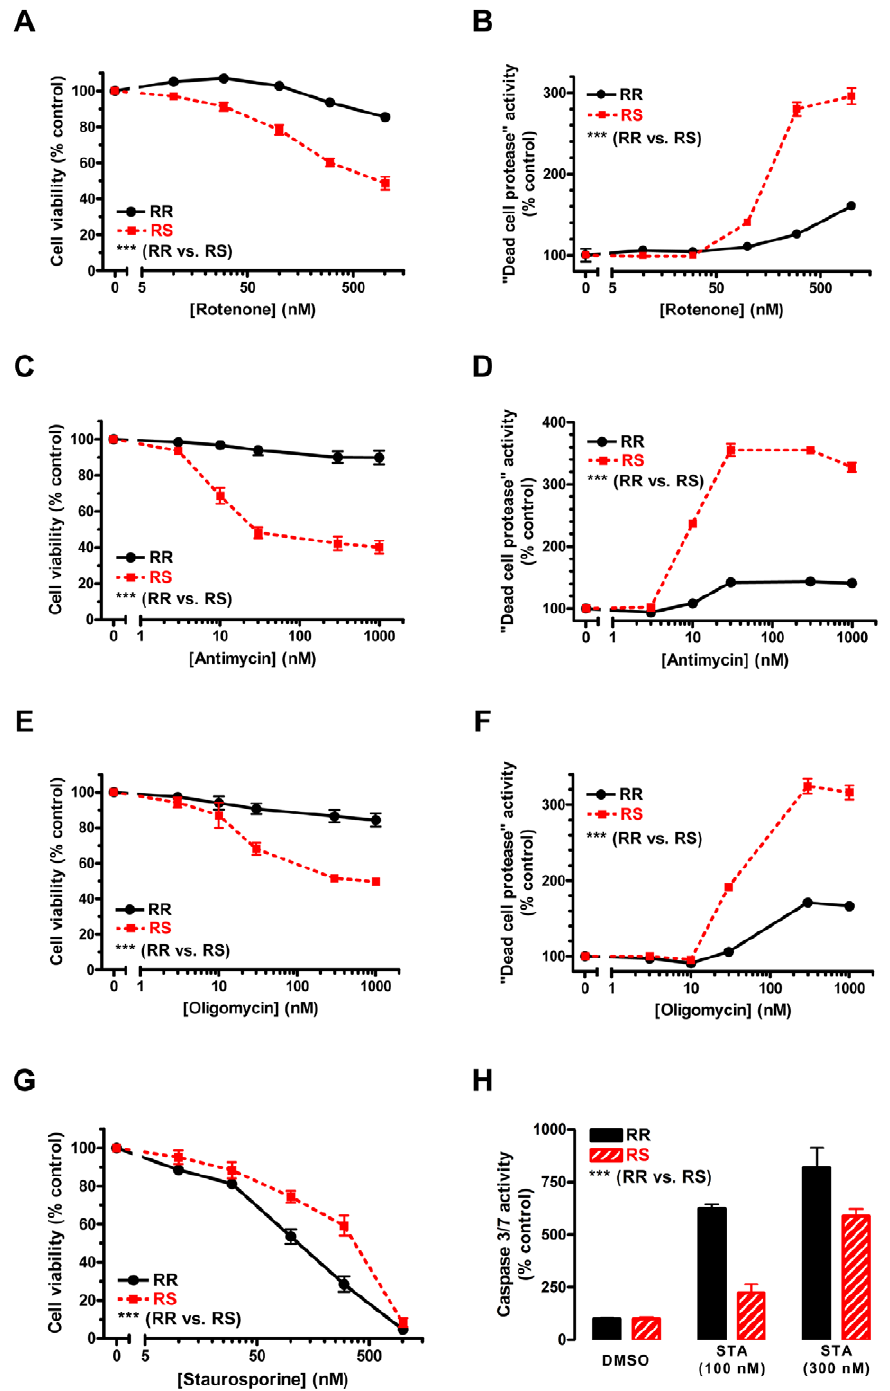
Figure 2. Differential vulnerability to mitochondrial inhibition and staurosporine-induced apoptosis. CRI-G1-RS cells are more vulnerable to cell death induced by mitochondrial respiratory chain inhibitors rotenone (panels A and B), antimycin (panels C and D), and oligomycin (panels E and F), but less vulnerable to apoptosis induced by protein kinase inhibitor staurosporine (panels G and H). Cell viability (panels A, C, E and G) was measured by CellTiter 96 AQ ueous One Solution Cell Proliferation Assay (‘‘MTS assay’’), a variant of the classic MTT assay; averaged data from 3– 6 repeat experiments are shown in each panel. Cell death (panels B, D, and F) was determined by CytoTox-Glo TM Assay, which measures the activity of a ‘‘dead-cell’’ protease released into the media from membrane-compromised cells; a representative of at least 3 repeat experiments is shown in each panel (n=4 in each experiment). Caspase 3/7 activity, an indicator of apoptosis, was measured by Caspase-Glo TM 3/7 Assay (panel H); a representative of 3 repeat experiments is shown (n=4 in each experiment). Although MTS assay is based on mitochondrial metabolism and thus could be directly affected by mitochondrial inhibitors, there was a good correspondence between viability and cell death assay results for all compounds tested. Statistical significance was determined by two-way ANOVA, which showed highly significant effect of both treatment and cell type in all conditions tested. Data are plotted as mean 6 S.E.M.; ***, p , 0.001. doi:10.1371/journal.pone.0014485.g002 PLoS ONE |